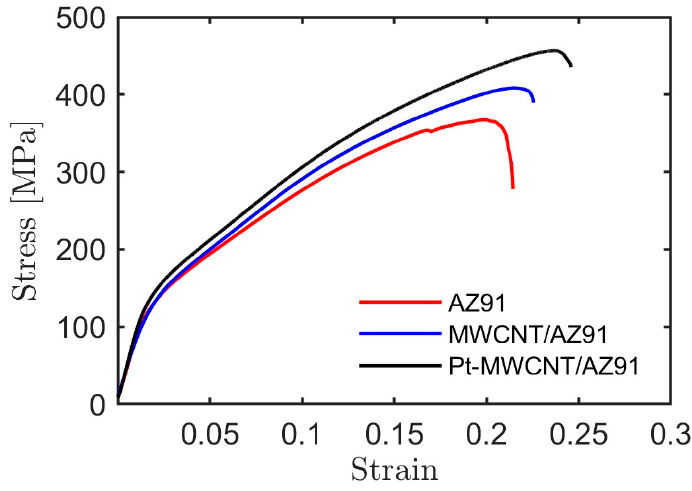
Figure 4. Typical stress-strain curves of pure AZ91, 0.05 wt% uncoated MWCNT/AZ91 composite, and 0.05 wt% Pt-MWCNT/AZ91 composite.